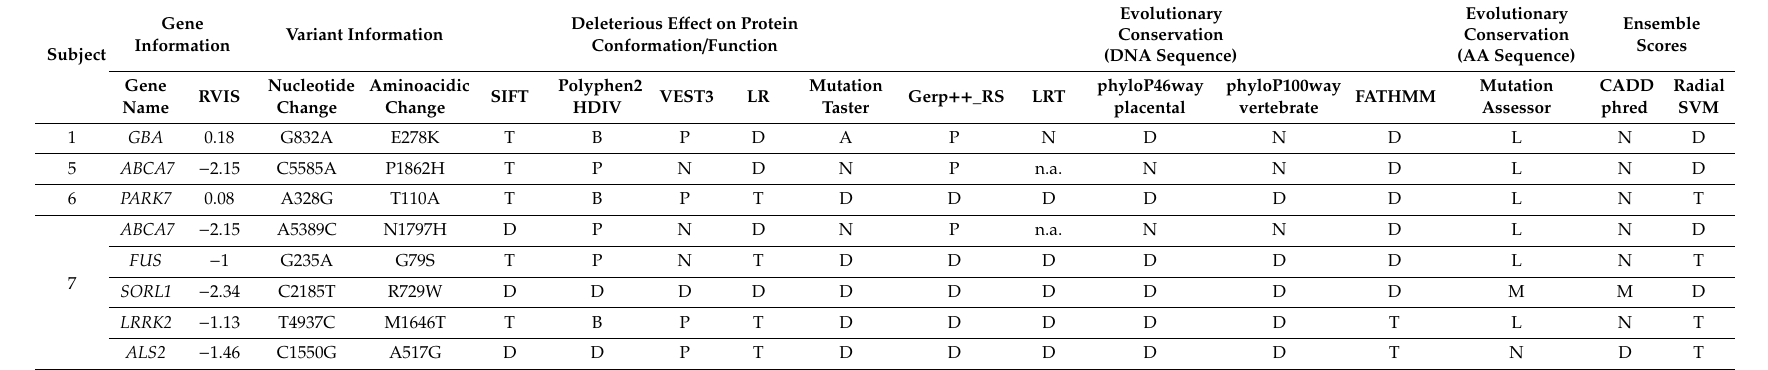
Table 3. In silico prediction of the pathogenicity of each identified rare